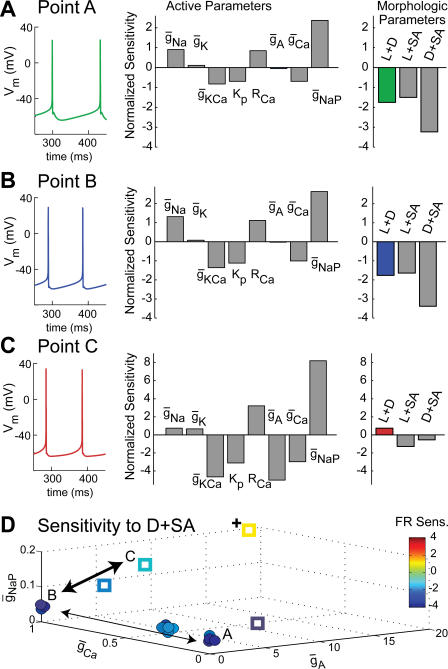
Sensitivity of Spontaneous Firing Rate to Model Parameters Varied Across Parameter Space(A–C) Somatic voltage traces and normalized sensitivity coefficients to perturbations of active (
,
,
, Kp, RCa,
,
,
) and morphologic (L + D, L + SA, D + SA) parameters, for the models labeled A, B, and C in Figures 3A and (D) (colored triangles). For some regions of parameter space (points A and B), the pattern of parameter sensitivities was similar. In other regions (C), the sensitivity to several parameters changed dramatically (compare colored bars in [A] and [B] versus [C]), so that the relative influence of different parameters on spontaneous firing rate was changed.
(D) Firing rate sensitivity to D + SA of all optimized models, as a function of their location in the [
,
,
] subspace. The points shown in (A–C) above are labeled (A, B, and C), with color indicating the magnitude and sign of firing rate sensitivity to D + SA according to the colorscale shown on the right. Arrows show the directions along which sensitivity to D + SA was relatively constant (thin arrow), and along which it changed substantially (thick arrow). Along this principal direction, even the sensitivity sign reversed (yellow circle, marked with “+”). In the 11 models shown as filled circles, firing rate sensitivity was largest to the morphologic parameter D + SA than to any active parameter. Open squares show the four models for which firing rate sensitivity was greater to at least one active parameter than to D + SA.